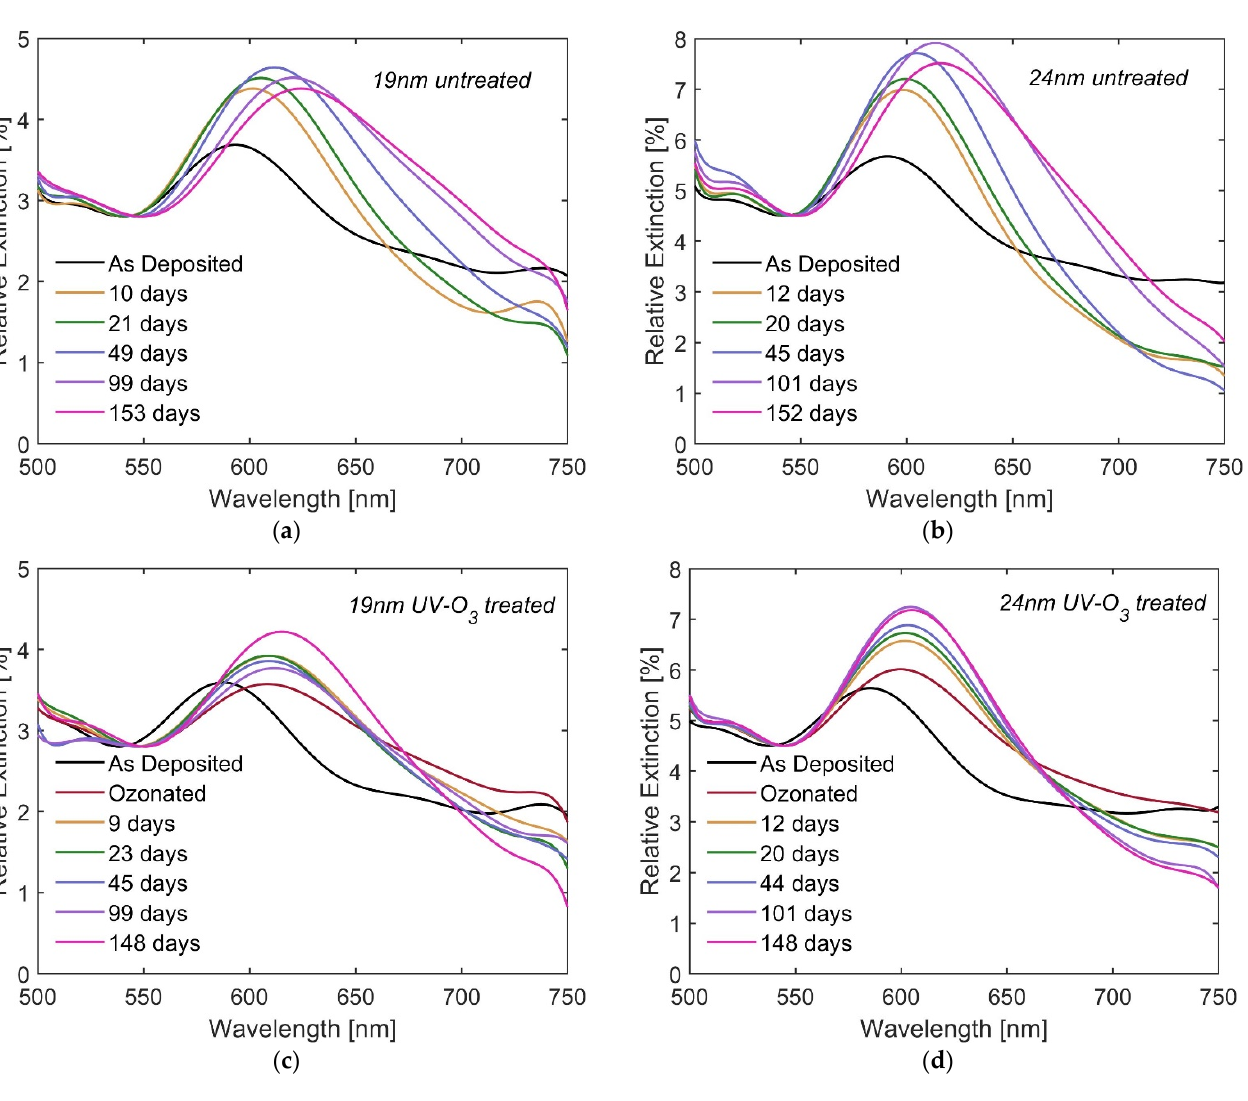
Figure 5. Relative extinction spectra of untreated ( a ) 19 nm and ( b ) 24 nm NPs as well as UV-ozone treated ( c ) 19 nm and ( d ) 24 nm NPs measured at selected days after the deposition. Both untreated and treated samples were kept in ambient atmosphere at room temperature between the measure- ments.